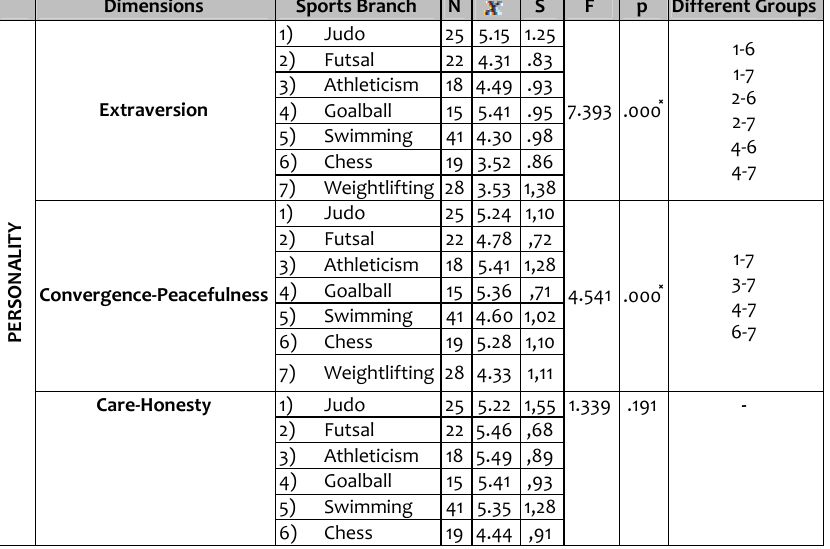
Table 5. Anova Test for Branch Variable Differentiation of Personality Traits Scores Average of the Visually Impaired Athletes who participated in the study for Branch Differentiation